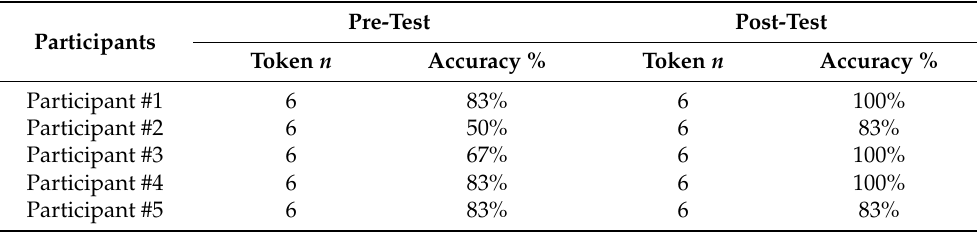
Table 5. General accuracy in multiple-choice questions in the pre- and